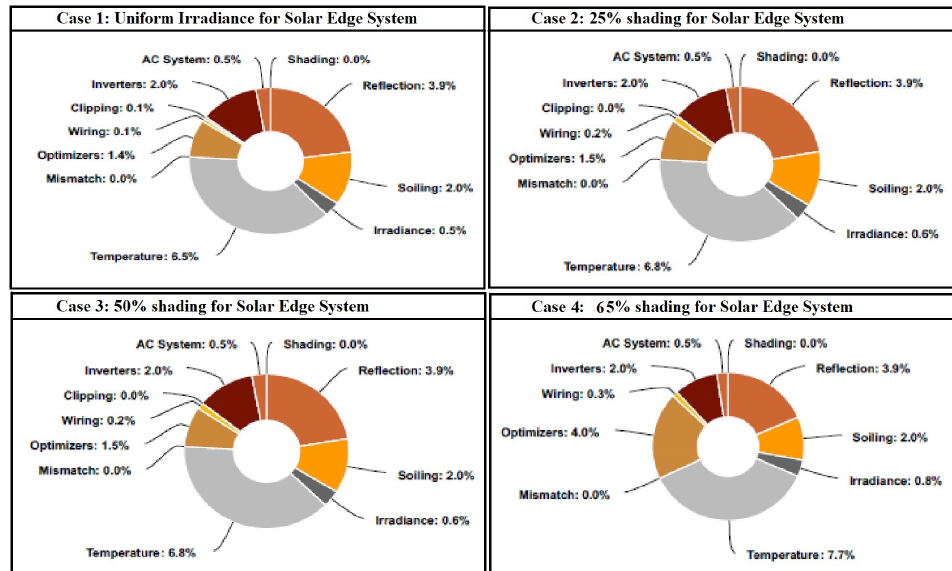
Figure 41. Results of various losses of Solar edge system on different shading conditions using